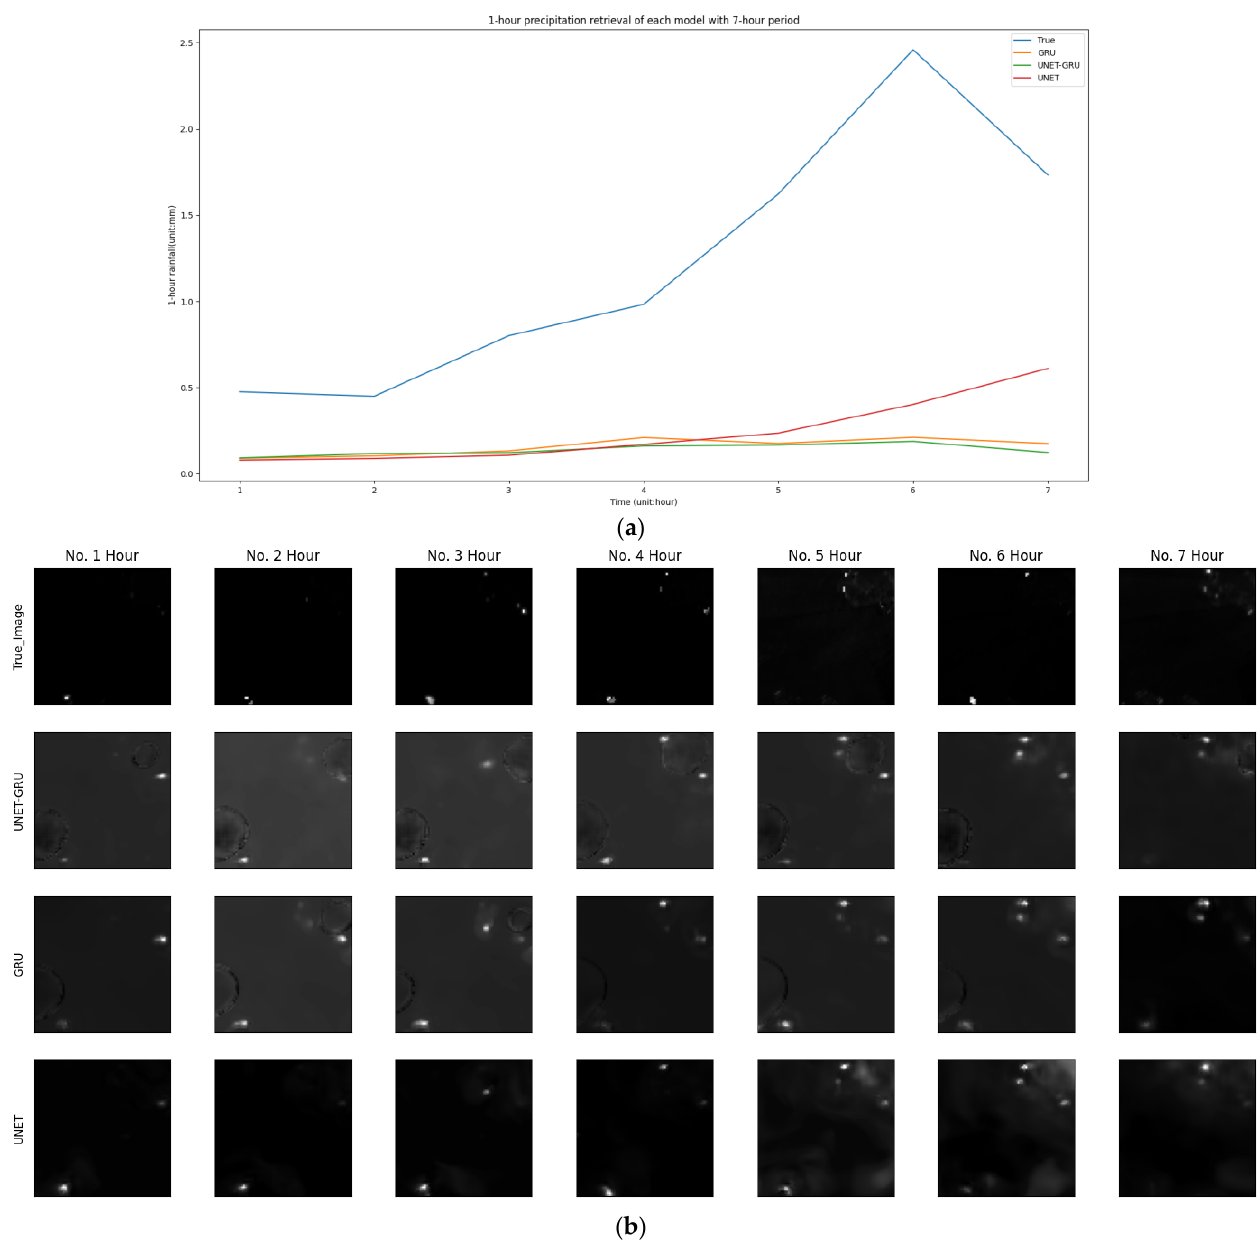
Figure 10. Comparison of 7-h grid and average rainfall inversion for a simulated artificial rainfall event in the Shiyan region. ( a ) Comparison chart of 1-h rainfall forecast and actual measurement values for each model (lasts for 7 h). ( b ) Comparison of 1-h grid-based rainfall forecasts and observed values from different models (lasts for 7 h).